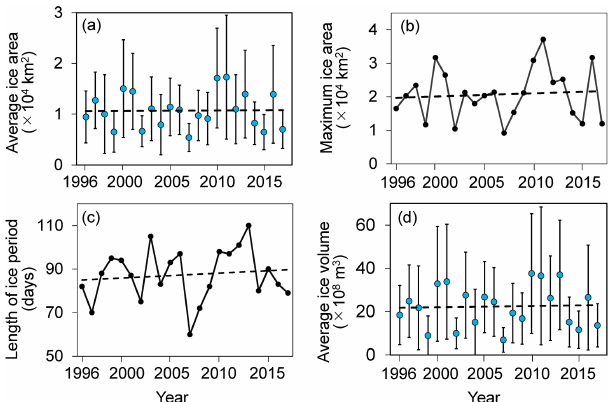
Figure 14. The annual average sea ice area (a) , the annual maxi- mum sea ice area (b) , the simulated length of ice period (c) , and the annual average sea ice volume (d) in the Bohai Sea from 1996 to 2017. The blue dots present the annual average values, and the er- ror bars stand for one standard deviation. The dotted lines represent 22-year trends obtained through the linear